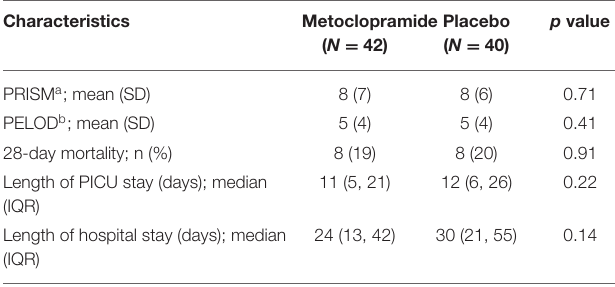
TABLE 2 | Severity, mortality, length of pediatric intensive care unit (PICU) stay, and length of hospital stay. Characteristics